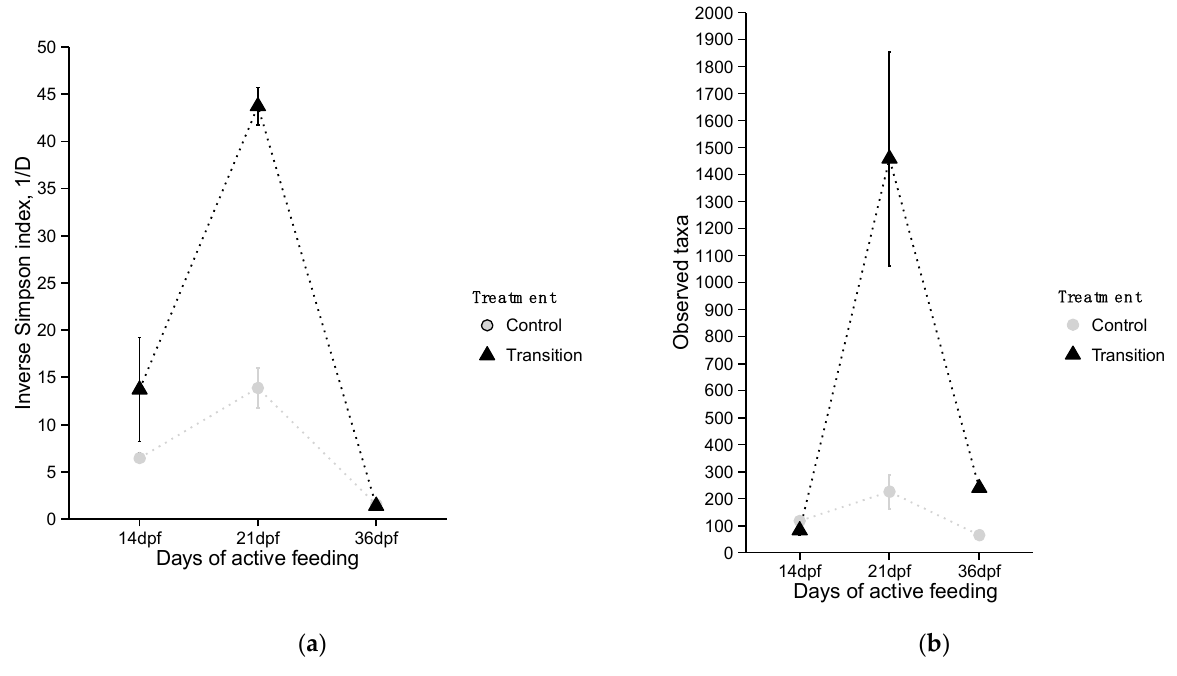
Figure 3. Measures of microbial community diversity including ( a ) inverse Simpson diversity index and ( b ) number of observed OTUs (taxa richness) for larval lake sturgeon from the control (CR) and transition (TR) feeding treatments at different sampling times.